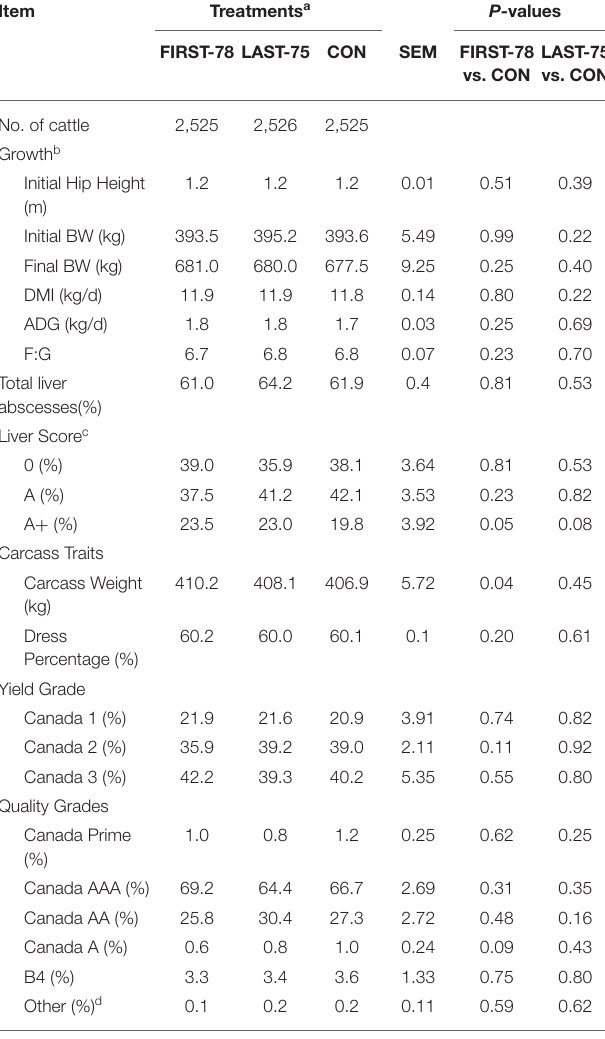
TABLE 4 | Growth performance, liver abscesses, and carcass traits of feedlot cattle from cattle fed tylosin for the FIRST-78% , LAST-75% , or continuously ( CON ) during the feeding